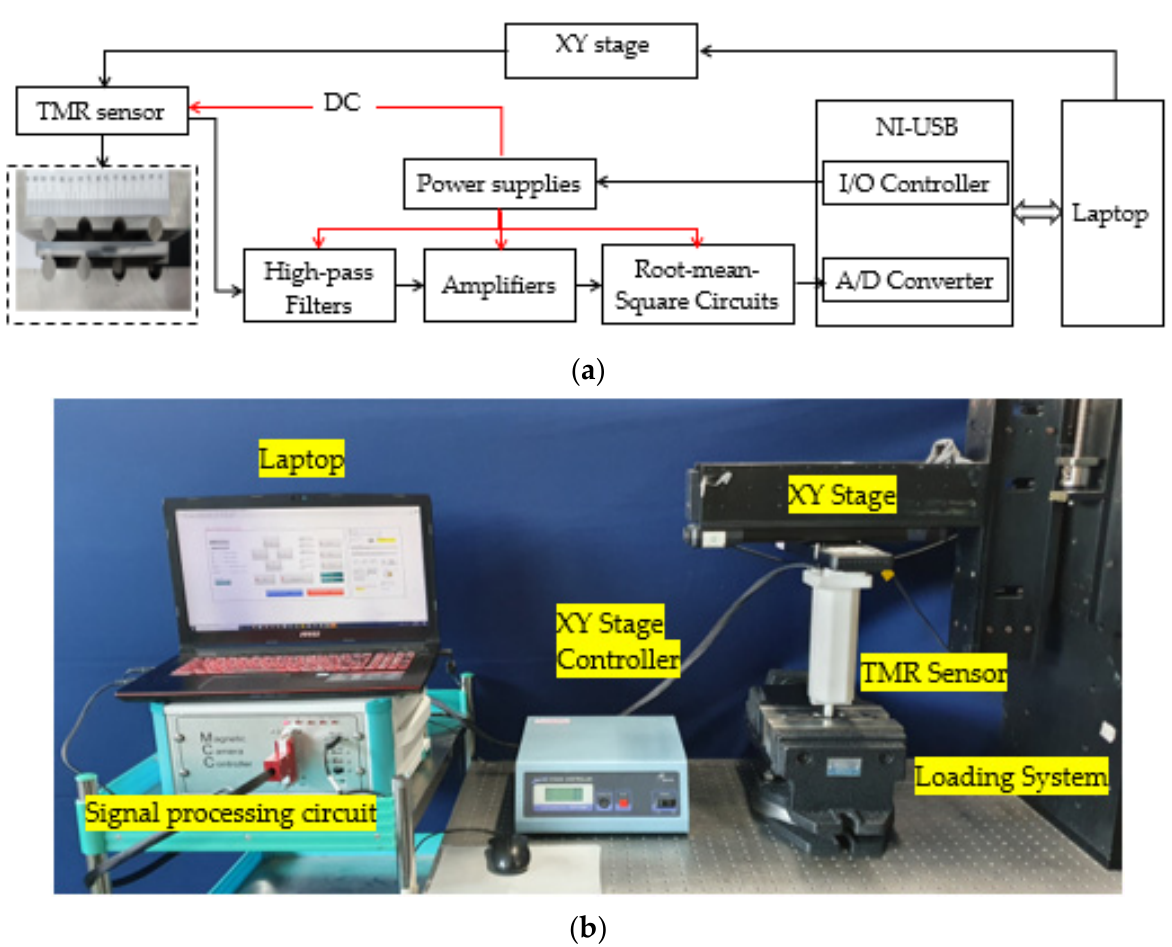
Figure 1. Experiment setup. ( a ) The inspection setup block diagram; ( b ) experimental equipment. Table 1. Properties of the SA 106 specimen.